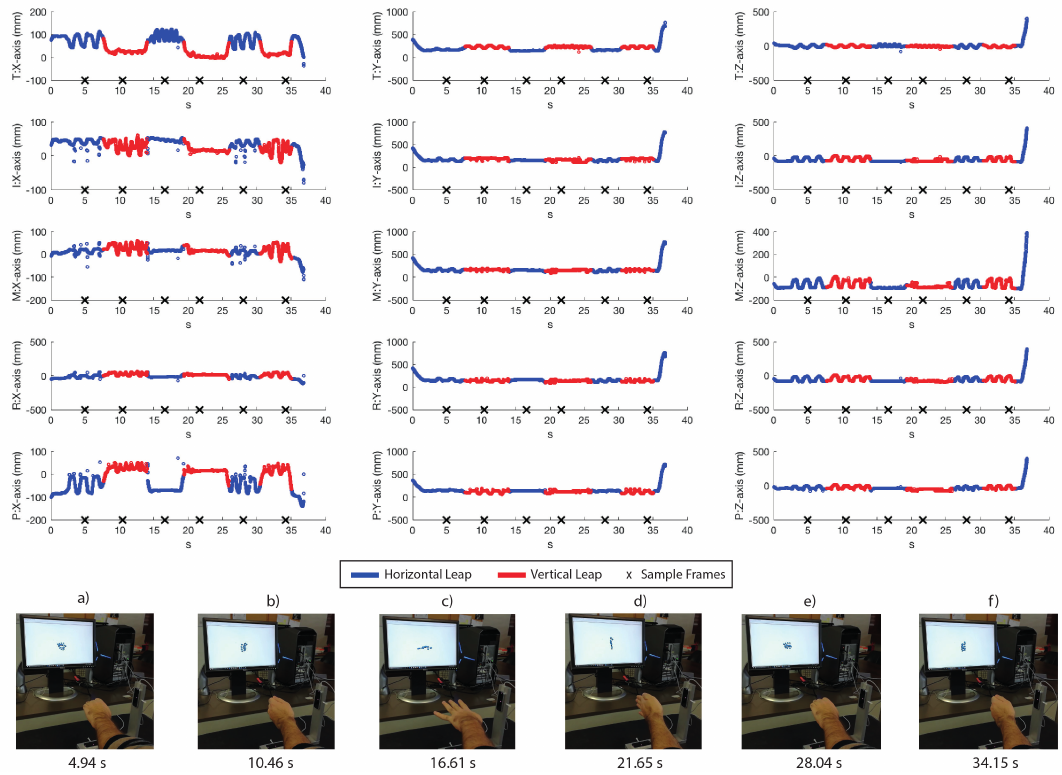
Figure 7. Real time VG tracking for each of the finger tips movements (T: thumb; I: index; M: middle; R: ring finger; and P: pinkie), for each of the three axes, registered for 37 s. In blue is indicated the horizontal LEAP signal used by VG and in red that of the vertical LEAP. In the low part, some snapshots, corresponding to the time instant indicated by crosses along the time axis, of an external video are reported for indicating the current hand orientation and fingers location and the corresponding visual model represented on a computer